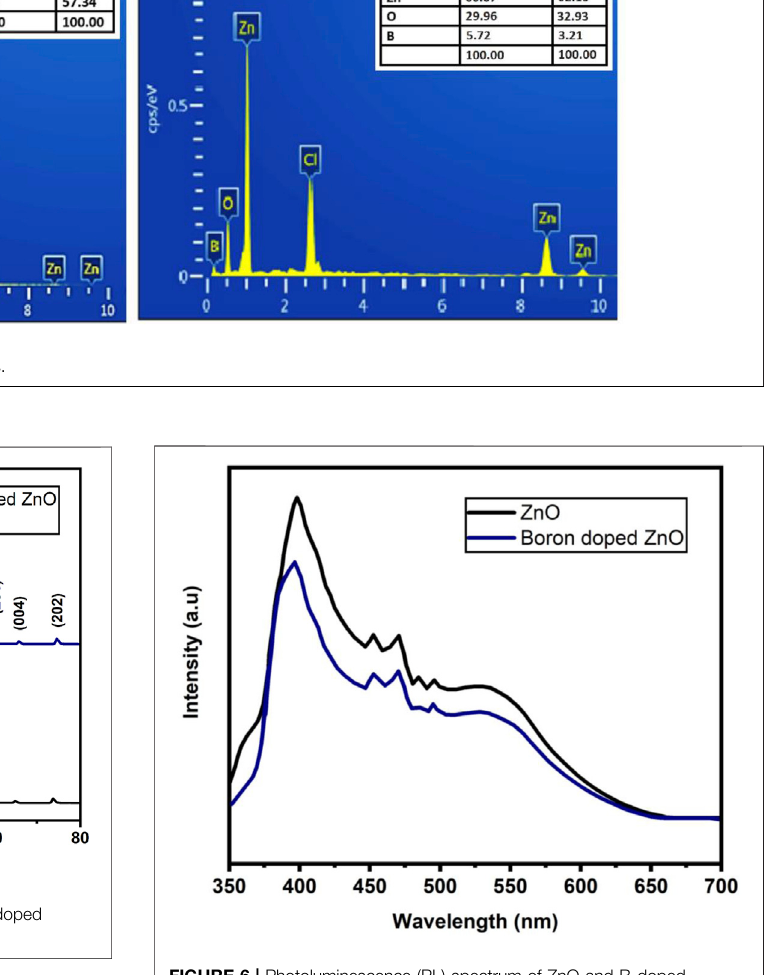
FIGURE 6 | Photoluminescence (PL) spectrum of ZnO and B-doped